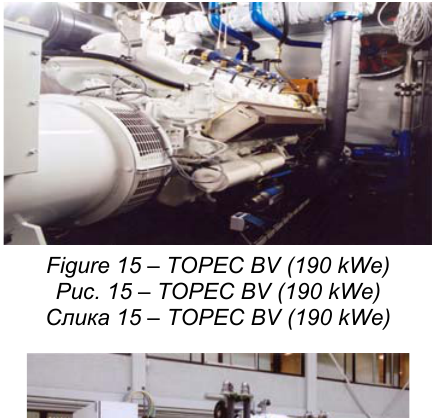
Figure 15 – TOPEC BV (190 kWe) Рис . 15 – TOPEC BV (190 kWe) Слика 15 – TOPEC BV (190 kWe)